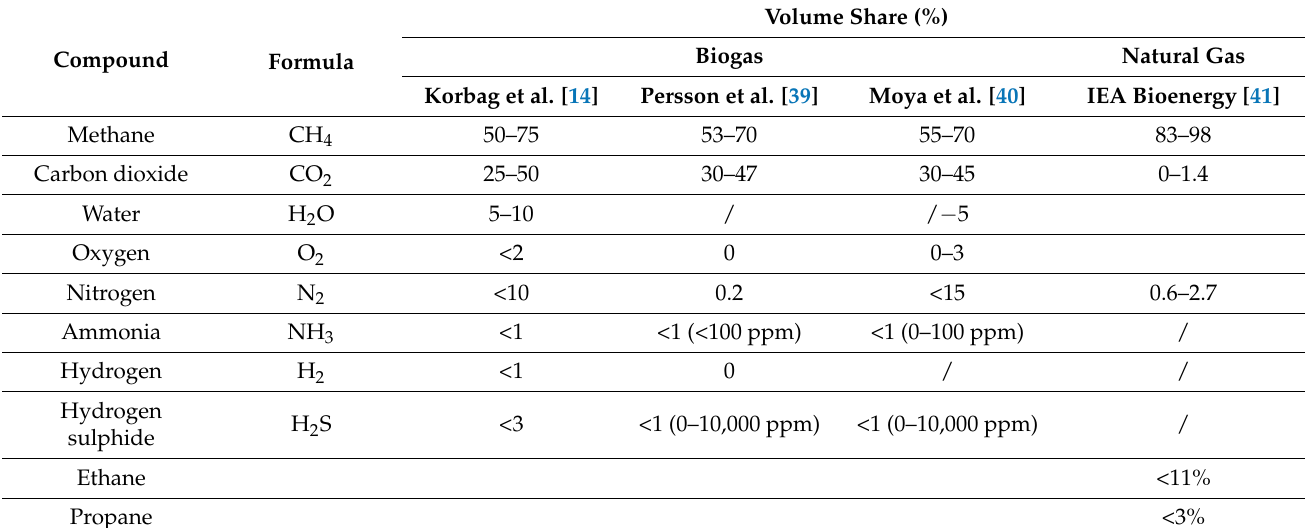
Table 1. Biogas vs. natural gas composition